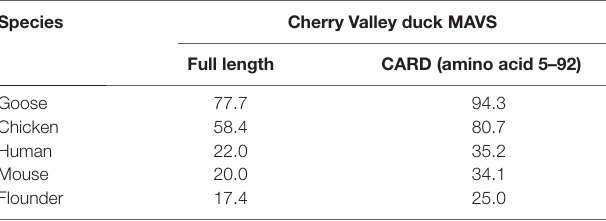
TaBle 2 | homology analysis of MaVs protein between cherry Valley ducks and other species (% amino acid sequence identities a ).